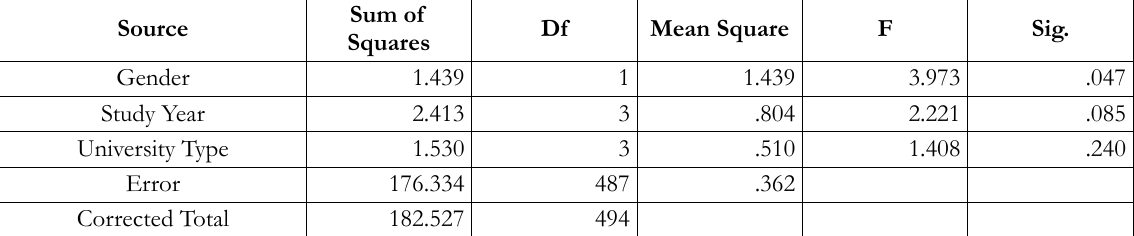
Table 4. 3 way ANOVA results of the students’ perceptions of flipped classroom in the Jordanian private universities as based on gender, study year and university